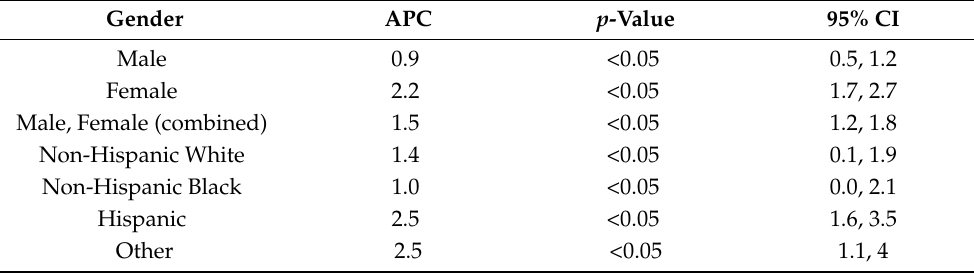
Table 2. Annual Percent Change by Sex and